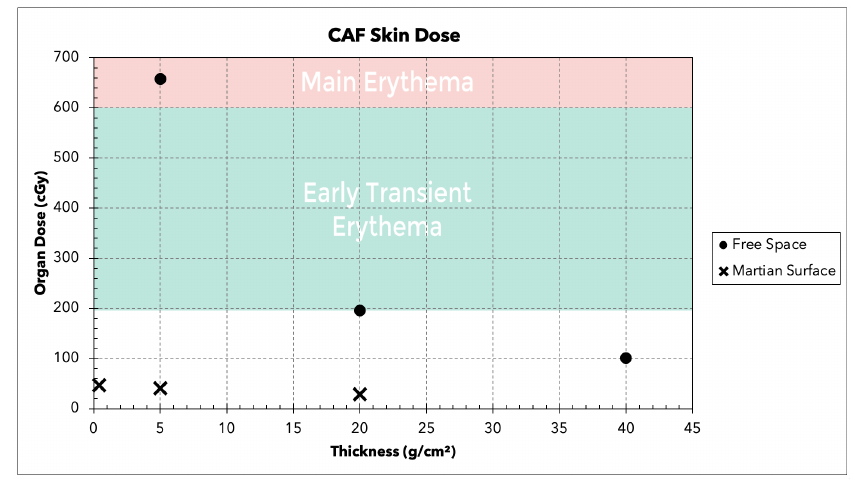
Figure 3. Skin doses from 993/4 SPE for CAF behind various thicknesses of aluminum shielding. The possible biological damage threshold regions are labeled in the background.